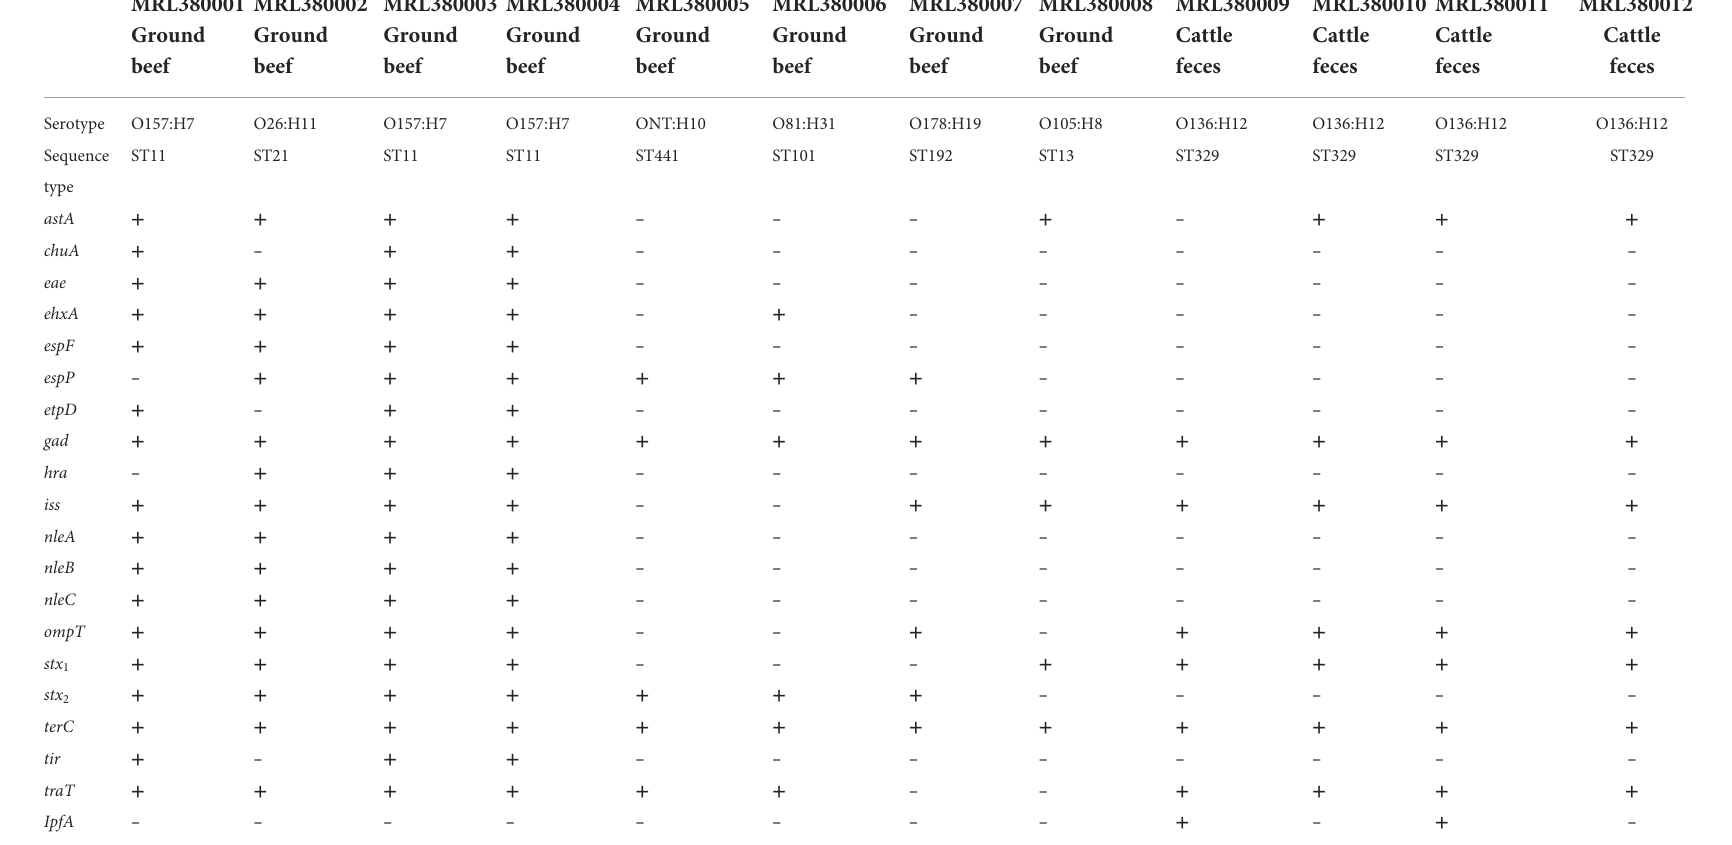
TABLE 3 Sequence types and virulence genes detected by WGS in 12 STEC strains in this study.